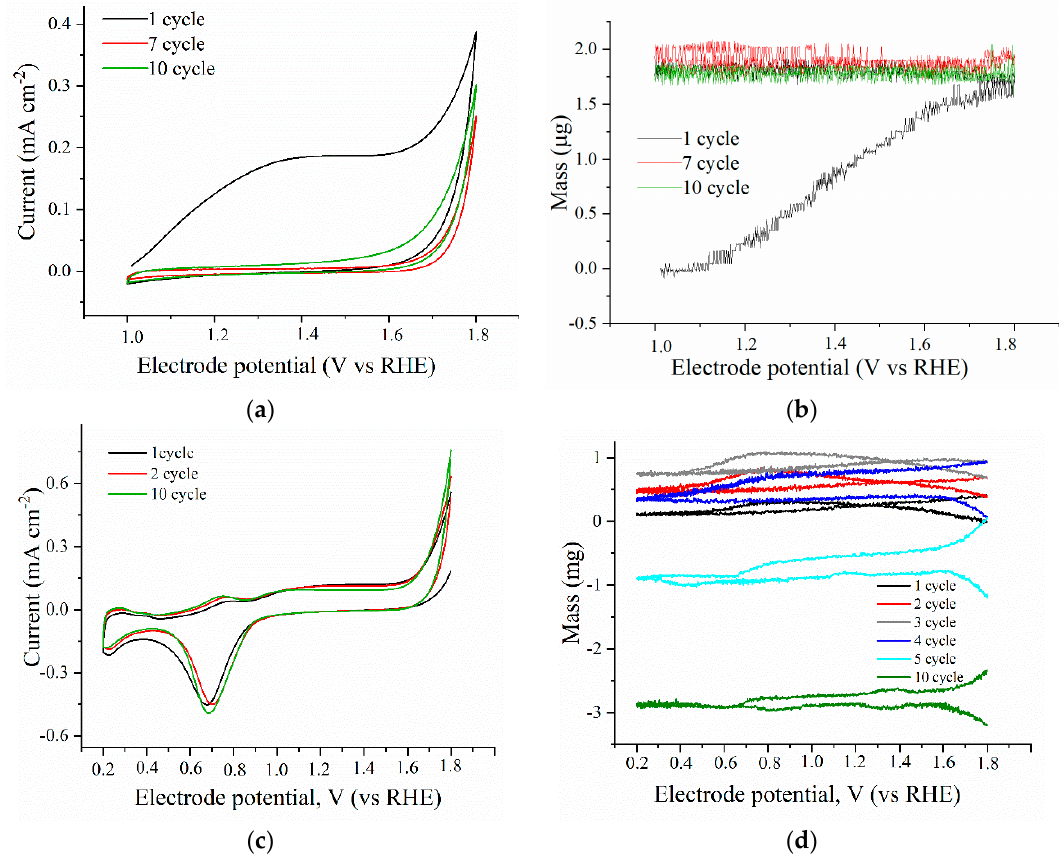
Figure 1. Alkaline hydrolysis of the Pt modified poly[Cu(Salen)] film in the oxygen-saturated 0.2 M NaOH solution with mass control by EQCM ( a ) cyclic voltammograms and ( b ) the polymer mass change in the potential range of 1–1.8 V (vs RHE); ( c ) cyclic voltammograms and ( d ) the polymer mass change in the wide potential range of 0.2–1.8 V (vs RHE).